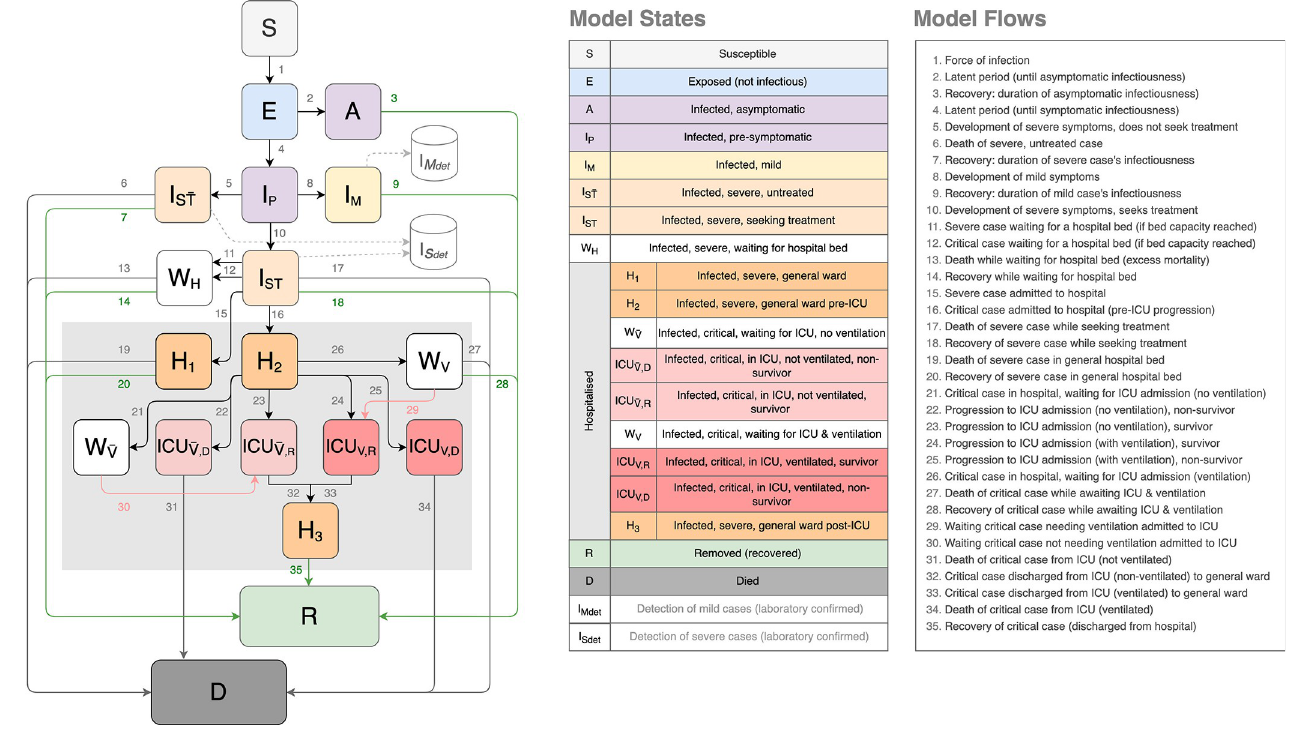
Fig 1. The National COVID-19 Epi Model structure (updated)